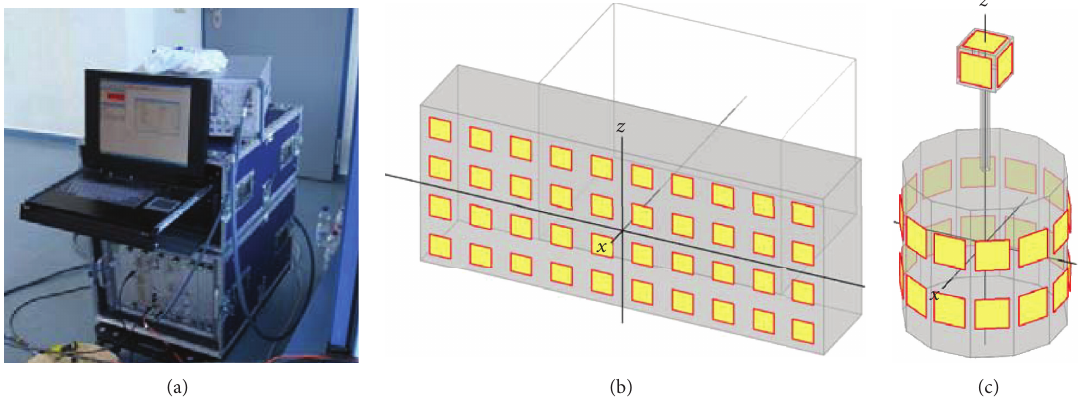
Figure 4: Measurement equipment: RUSK sounder (Tx) and antenna arrays—PULA8 (Tx) and SPUCA12 + MIMO-Cube (Rx).